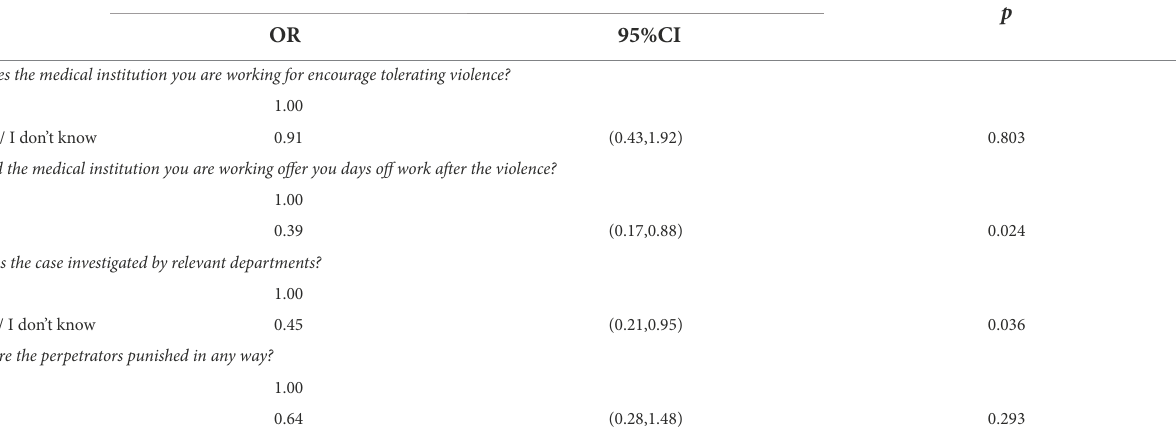
TABLE 5 Regression coefficients for the health sector workers’ satisfaction and potential remedial measures with adjustment for social demographic